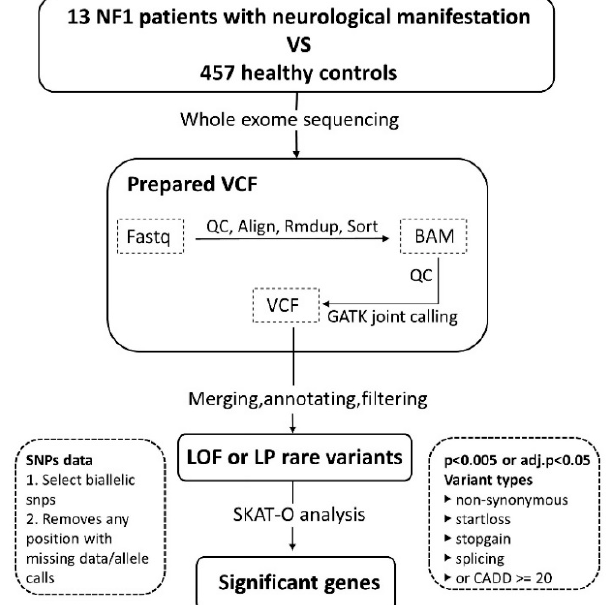
Figure 1. Workflow of rare-variant association analysis. In this study, we recruited 13 NF1 patients and 457 healthy controls and performed whole-exome sequencing for subsequent analysis. VCF files were generated following the best-practice guideline of GATK and rare-variant association analysis was based on the SKAT-O method using LOF/LP